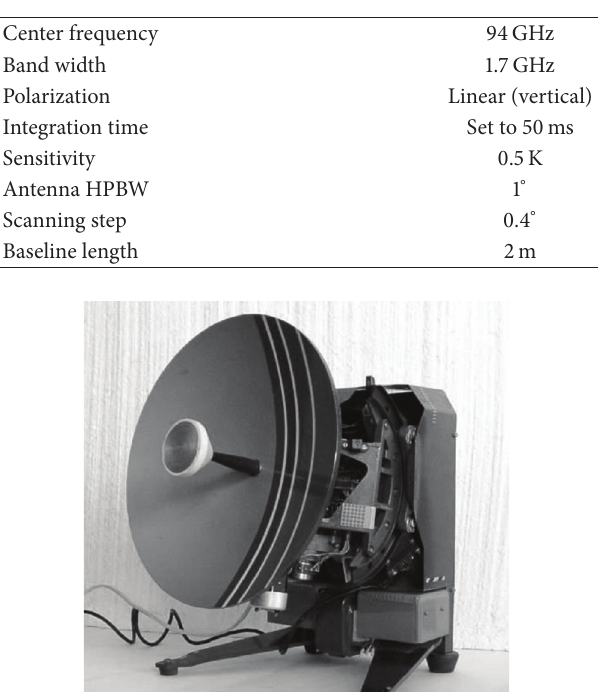
Table 1: Instrument specifications for the experiment.